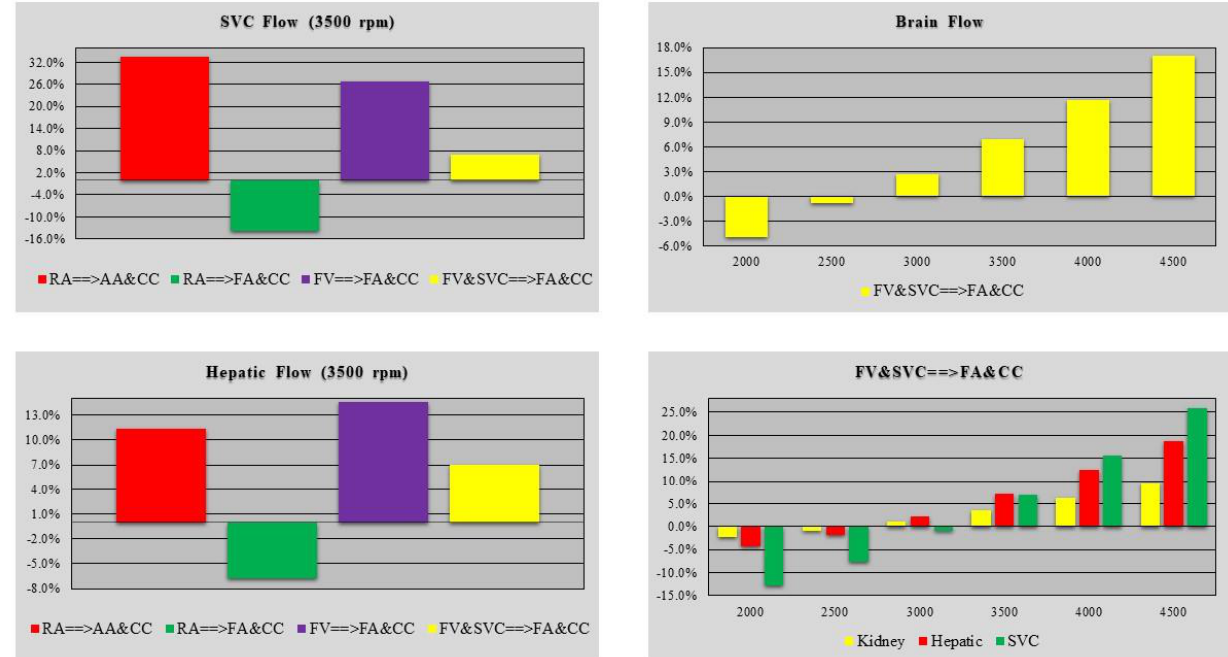
Figure 13. The top (bottom)-left panel shows the relative changes in SVC flow (hepatic flow) induced by four different cannulation strategies obtained when the pump rotational speed was set to 3500 rpm. The top (bottom)-right panel shows the cerebral flow (kidney, hepatic and SVC flow) for FV&SVC → FA&CC cannulation method when the pump rotational speed was set to 2000, 2500, 3000, 3500, 4000 and 4500 rpm.